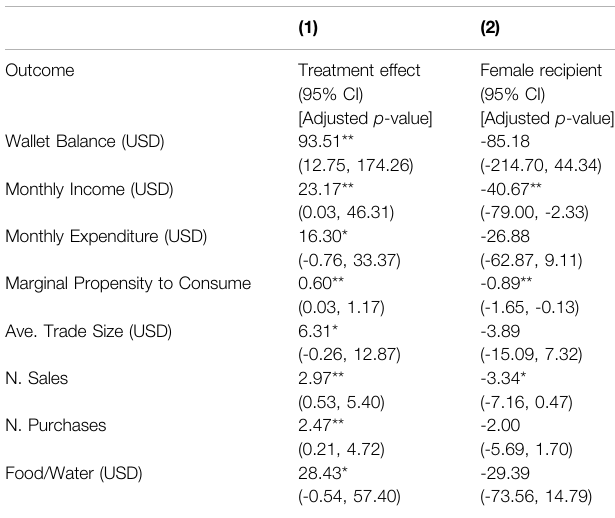
TABLE 5 | Treatment effects on outcome variables after 2